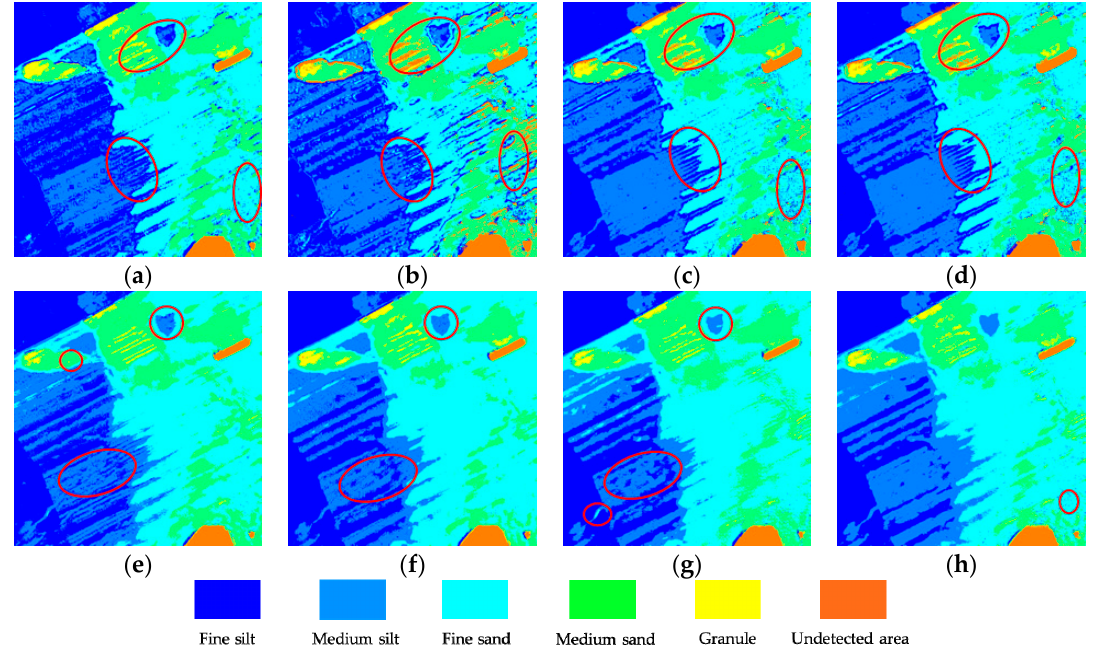
Figure 9. Image classification results of various classifiers on the Z1 area: ( a ) random forest (RF), ( b ) support vector machine (SVM), ( c ) GA-SVM, ( d ) PSO-SVM, ( e ) ELM, ( f ) RELM, ( g ) GA-RELM, and ( h ) our MELM. Several areas are marked to show the classification performance.